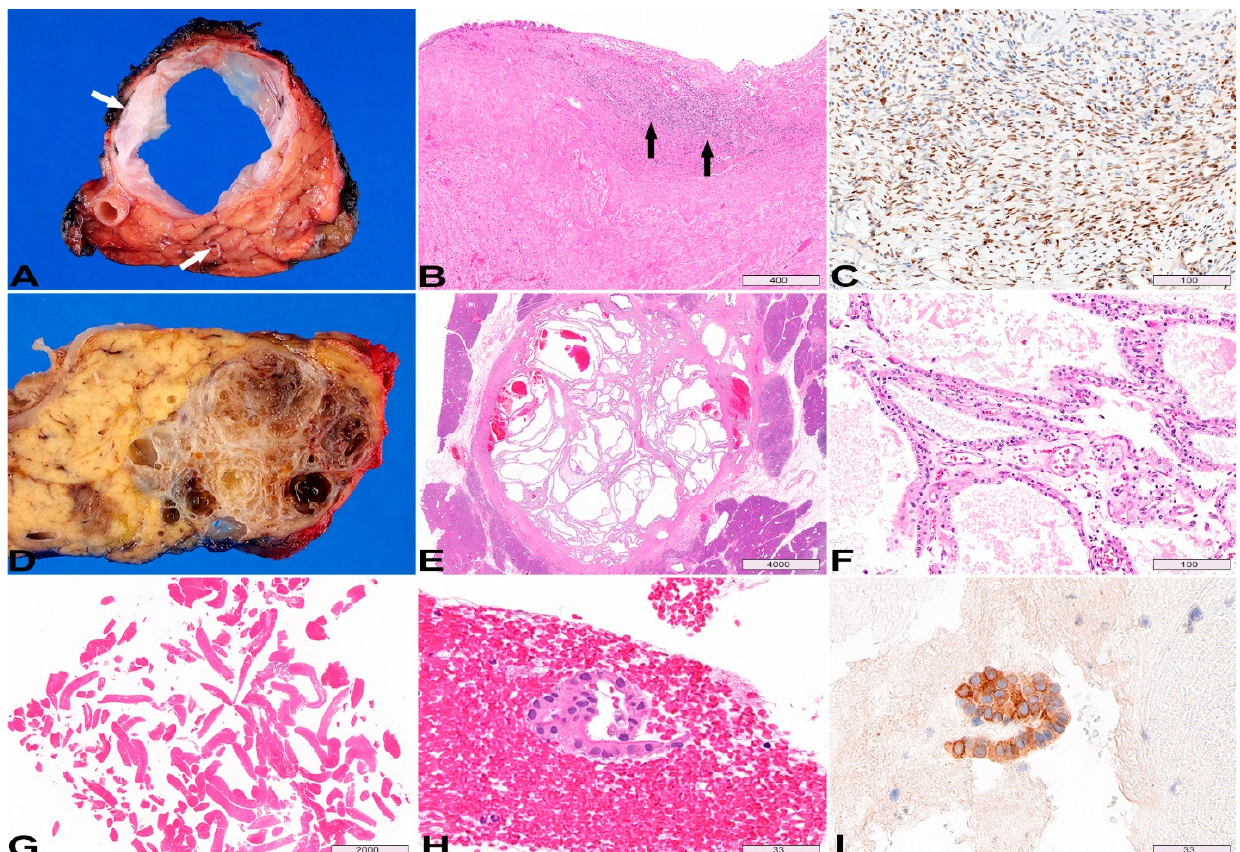
Figure 5. Mucinous cystic neoplasm (MCN, A-C) and serous cystadenoma (SCA, D-I). ( A ) Gross photo of the cut surface of a resected MCN, notice the thick fibrous wall (top arrow). It does not communicate with the pancreatic duct (bottom arrow). ( B ) Sections of the MCN shows focal residual epithelium (top left) with large area of denudation. The subepithelial ovarian-type stroma is required for the diagnosis of MCN (arrows). ( C ) Progesterone receptor is positive in the ovarian-type stroma by immunohistochemistry. ( D , E ) Cut surfaces of a resected microcystic SCA, characterized by thin, smooth-walled cysts with a sponge or honeycomb appearance. ( F ) Microscopically, the epithelium is flat with clear cuboidal cells and prominent underlying capillary network. ( G ) Microforceps biopsy of SCA typically yields predominantly bloody contents. ( H ) Rare minute strip of non-mucinous epithelial cells is present. ( I ) The neoplastic epithelium is immunoreactive for inhibin, which can be helpful for the diagnosis of SCN in small biopsy or cytology specimens. ( B , E – H ), H&E stain, ( C ), progesterone receptor immunostain, ( I ), inhibin immunostain; original magnification, ( B ) 50 × , ( C ) 200 × , ( E ) 5 × , ( F ) 200 × , ( G ) 10 × , ( H , I ) 600 × . Scale bars, in µ